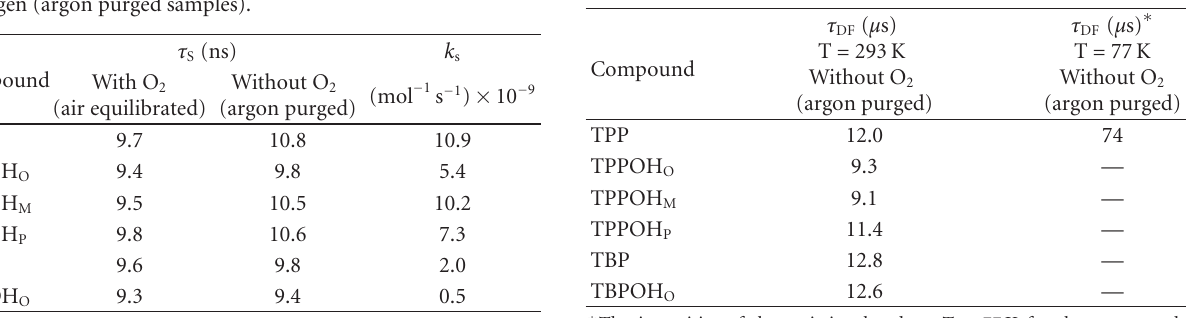
Table 3: Delayed fluorescence lifetime, τ DF , for the series of unsymmetrically substituted mesoporphyrins in benzene (at room temperature, in the absence of oxygen) (argon purged